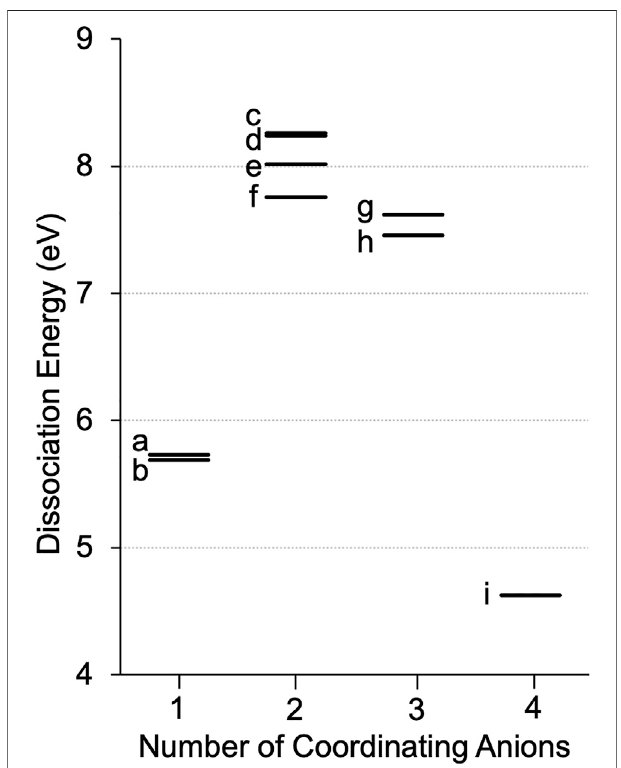
FIGURE4| Integraldissociationenergies, E D ,forLisolvateswith[CTFSI] according to the numbers of coordinating anions. Labels a – i correspond to structures shown in Figure 3 .